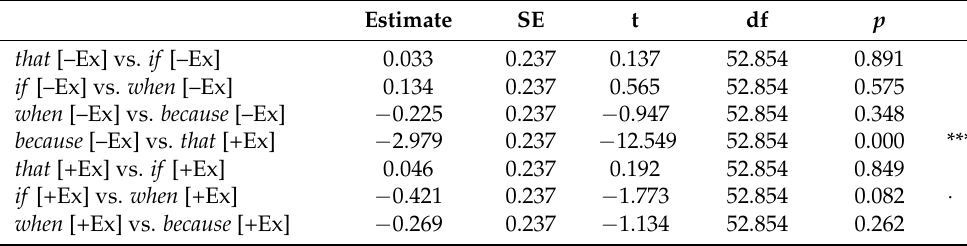
Table 4. Summary of the mixed effects model for filler type 1 (subject islands). Significance indicators: *** p < 0.001, marginal: · p < 0.1.